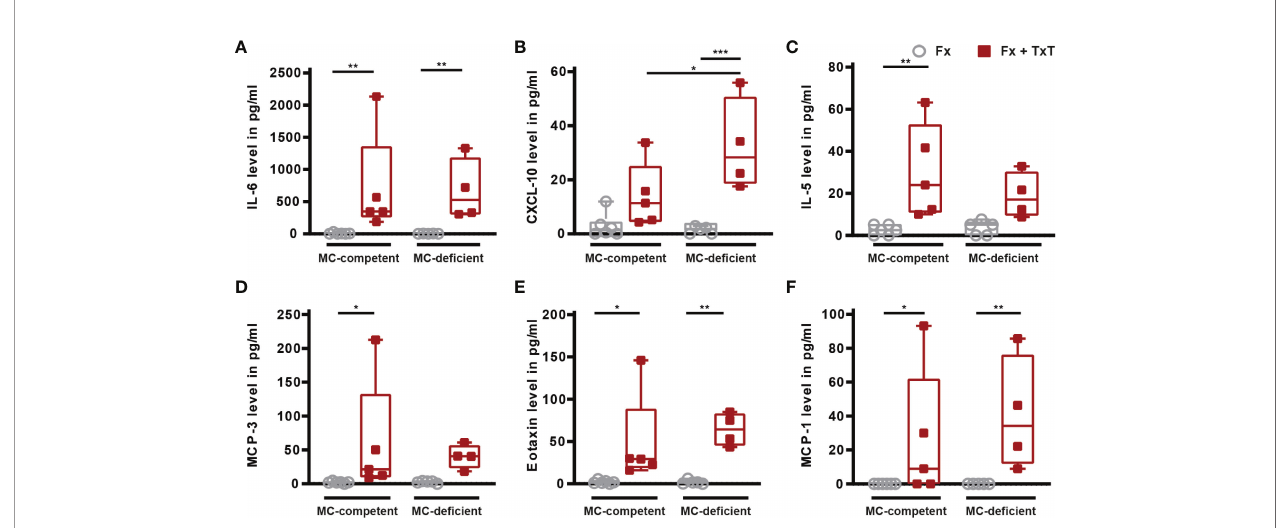
FIGURE 3 | In fl ammatory mediator concentrations in bronchoalveolar lavage (BAL) fl uid samples of mast cell (MC)-competent and MC-de fi cient mice 3 h after isolated fracture (Fx) and combined fracture and thoracic trauma (Fx + TxT). BAL fl uids (A) interleukin-6 (IL-6), (B) C-X-C motif chemokine ligand 10 (CXCL-10), (C) IL-5, (D) monocyte chemoattractant protein-3 (MCP-3), (E) eotaxin, and (F) MCP-1 levels. Gray boxes represent Fx mice, red boxes represent Fx + TxT mice. Data are shown as box-and-whisker plots (with median and interquartile range) from maximum to minimum, showing all data points. *p<0.05; **p<0.01; ***p<0.001. The p values were determined using one-way ANOVA with post hoc Fisher ’ s LSD in the case of normal distribution or with Kruskal-Wallis with post hoc Dunn ’ s test if data were not normally